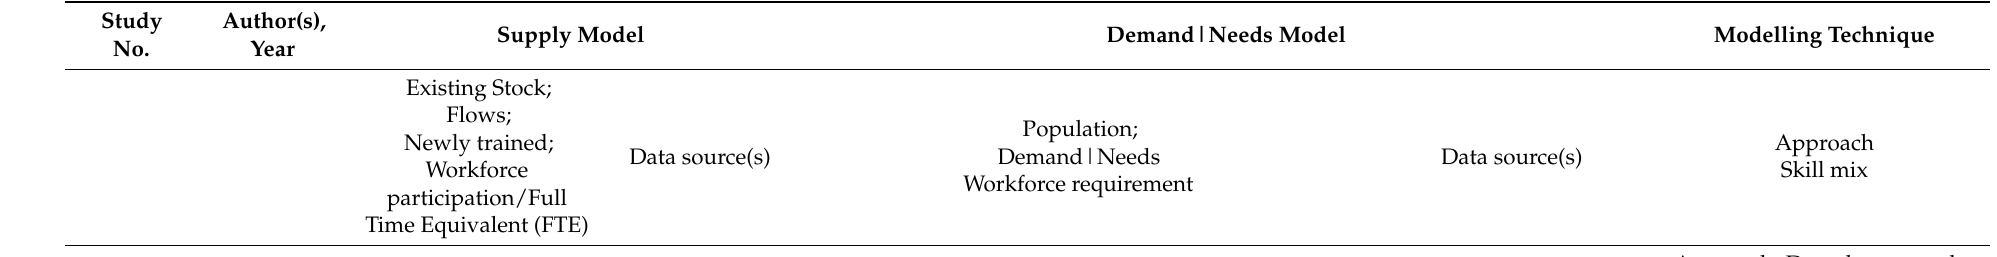
Table 2. Detailed characteristics of supply and demand/needs model of selected